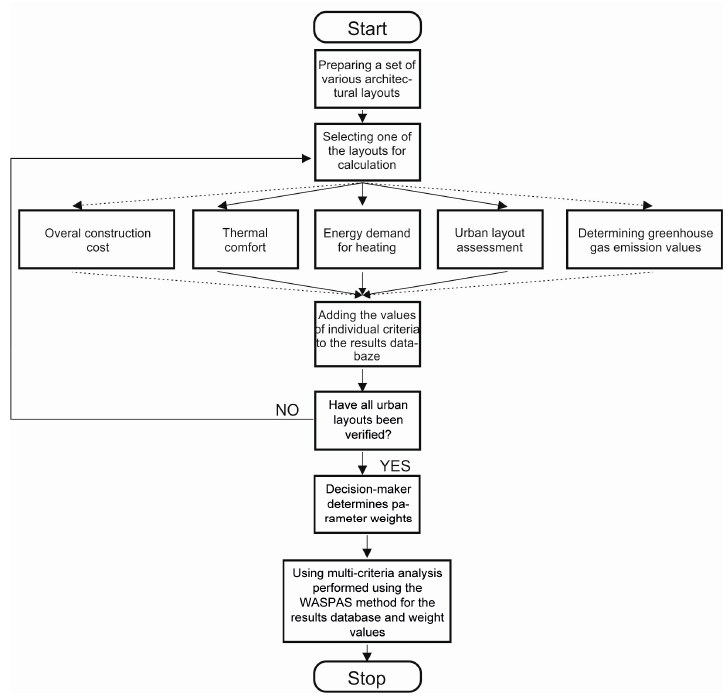
Figure 1. Method of selecting the urban layout of a complex of single-family houses.